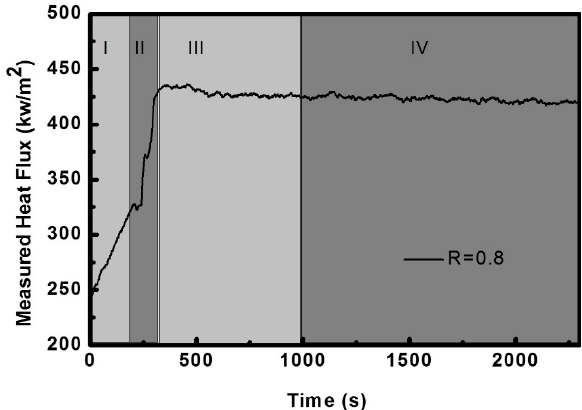
Figure 8. The heat flux time span of Sample R0.8A7 during the heat transfer test.